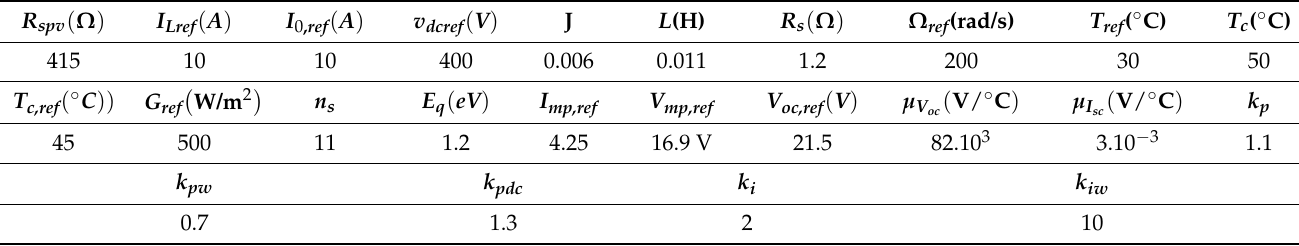
Table 1. System parameter